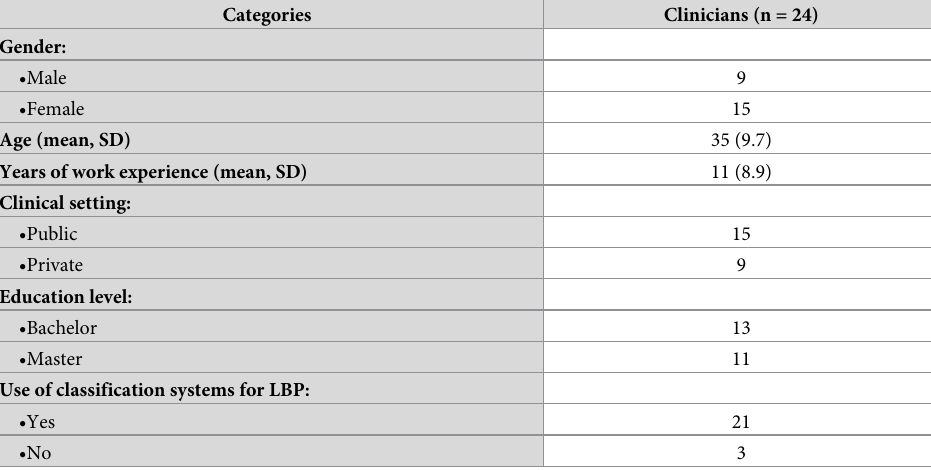
Table 2. Characteristics of